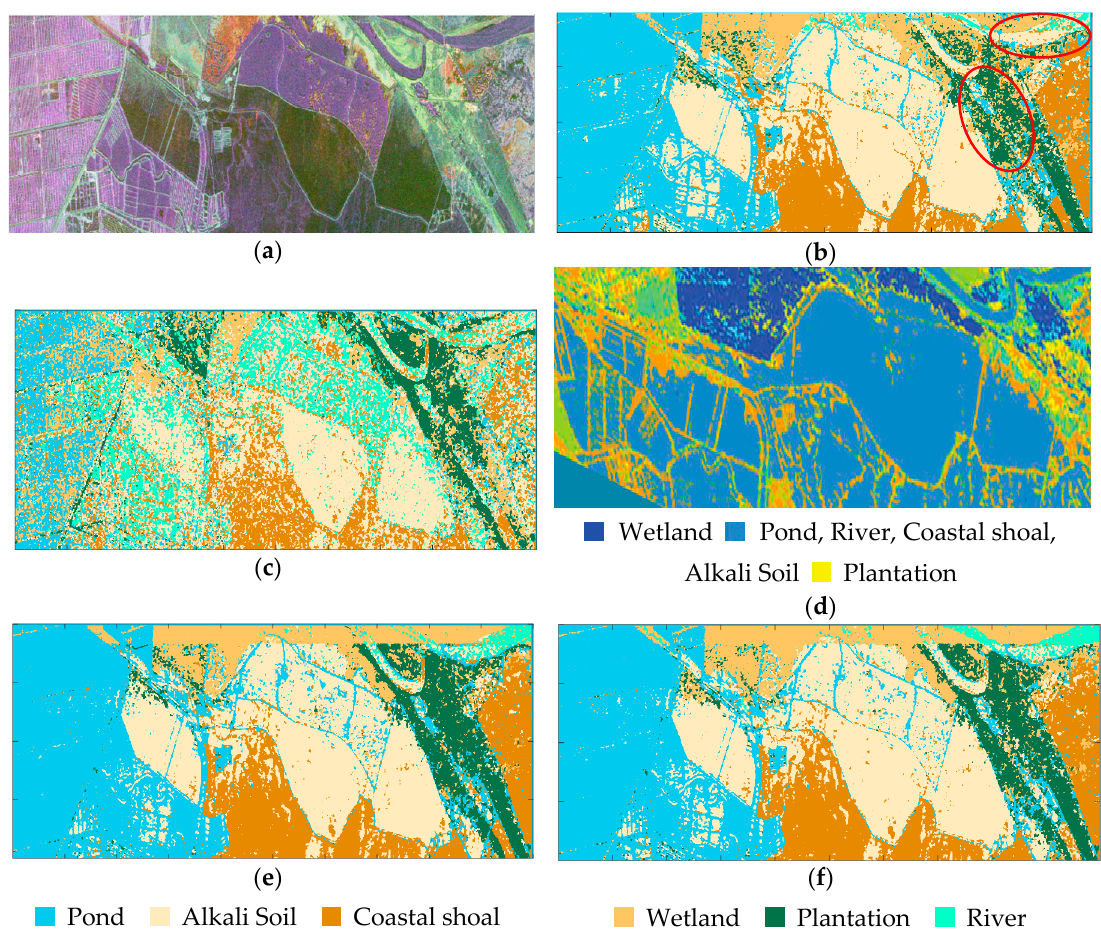
Figure 9. The classification results of the sub-image. ( a ) Pauli RGB; ( b ) SVM; ( c ) SRC; ( d ) WC; ( e ) MAE; ( f ) SPLMAE. Table 3. The accuracies of the Yellow River Delta. AA: average accuracy; OA: overall accuracy.